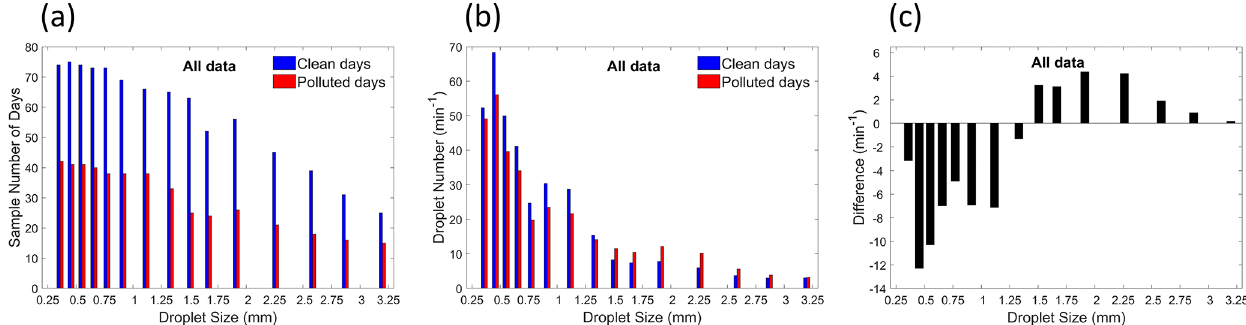
Figure 10. Multiyear (2005–2017) (a) JWD sample number of days in each raindrop size bin, (b) mean droplet number per minute for clean and polluted days, and (c) the differences in the mean droplet number between polluted and clean days. The droplet size for each bin is, in order, 0.359, 0.455, 0.551, 0.656, 0.771, 0.913, 1.116, 1.331, 1.506, 1.665, 1.912, 2.259, 2.584, 2.869, and